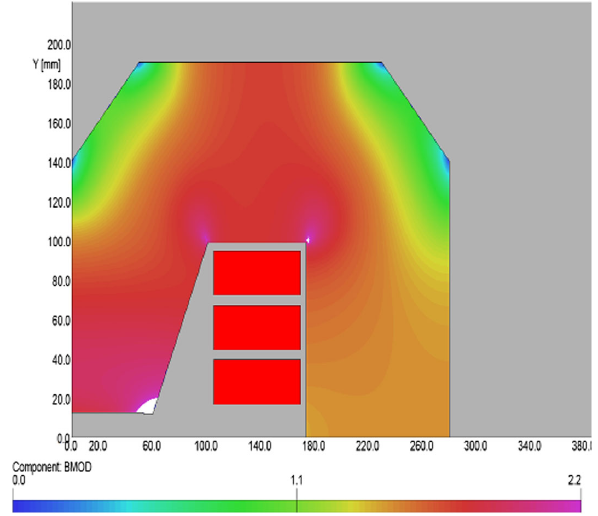
FIG. 7. FeCo magnet 2D flux density simulation.